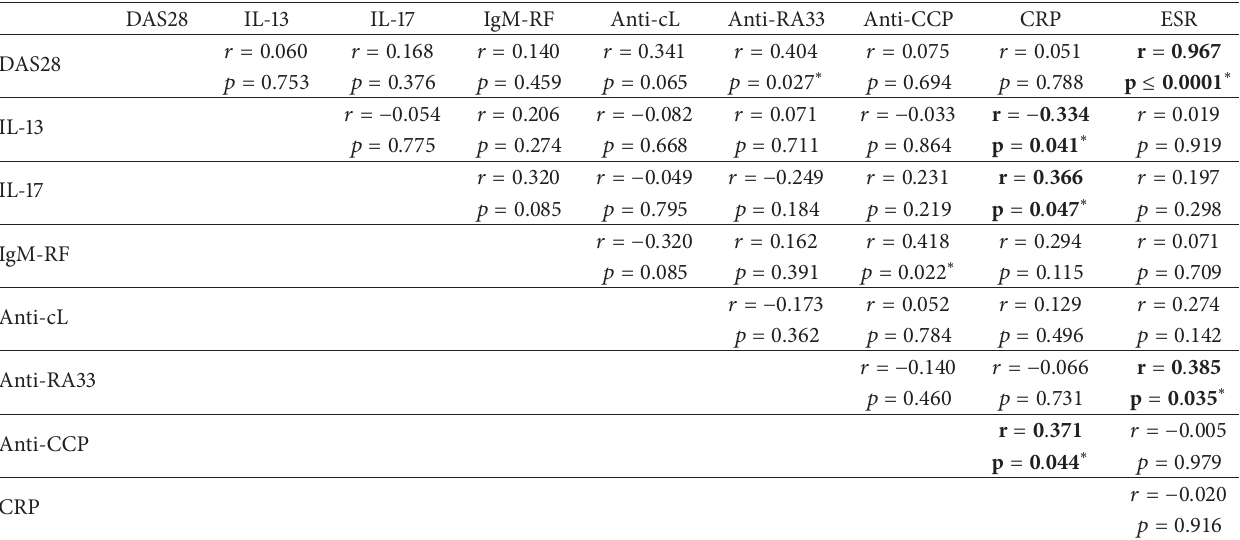
Table 3: Correlations between IL-13 and IL-17 and eRA